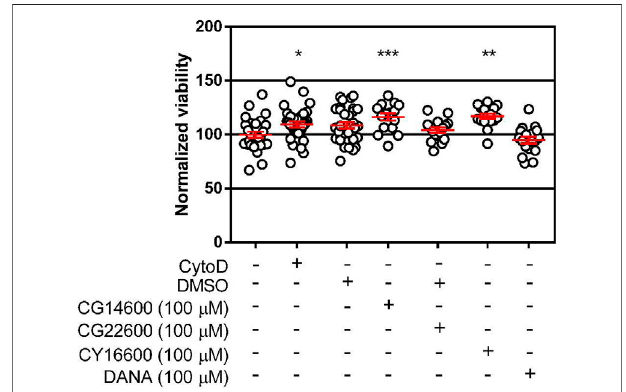
FIGURE5| Viabilityofcellsaftertreatmentwithinhibitors.Viabilityofcells was tested after treatment with the highest concentrations of inhibitors used for transmigration studies. Jurkat Tcells (5× 10 4 cells) wereincubated ineach well of a clear 96-well plate with the indicated inhibitors for 21 h. After incubation, MTS was used to determine cell viability after 1 h incubation. Data are plotted as the mean ± SEM and compared to control using a Dunnett ’